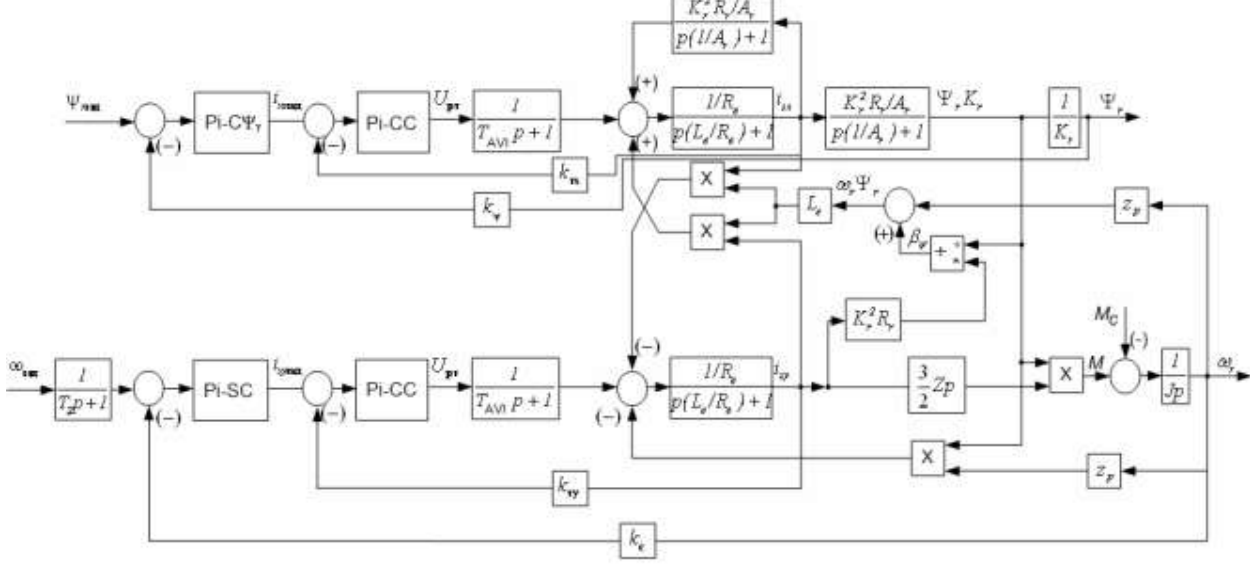
Figure 1. Simplified structure diagram of variable frequency vector control of the induction motor drive